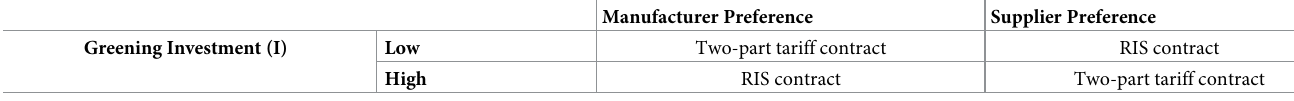
Table 3. Contract preferences of manufacturer and supplier at low and high values of I.